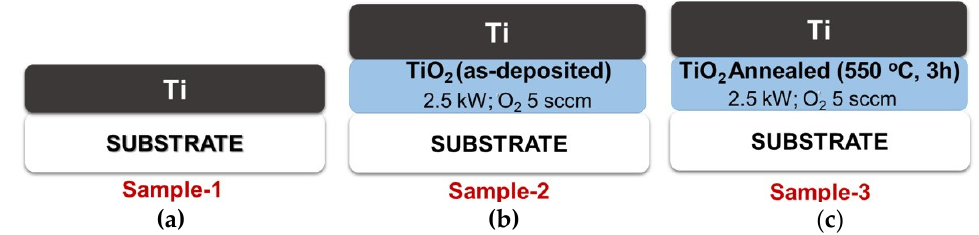
Figure 1. Sample preparation: ( a ) sample 1, Ti films; ( b ) sample 2, bottom layer of TiO2 (as-deposited) + upper layer of Ti films; and ( c ) sample 3, bottom layer of TiO2 (annealed) + upper layer of Ti films, deposited onto a glass substrate.